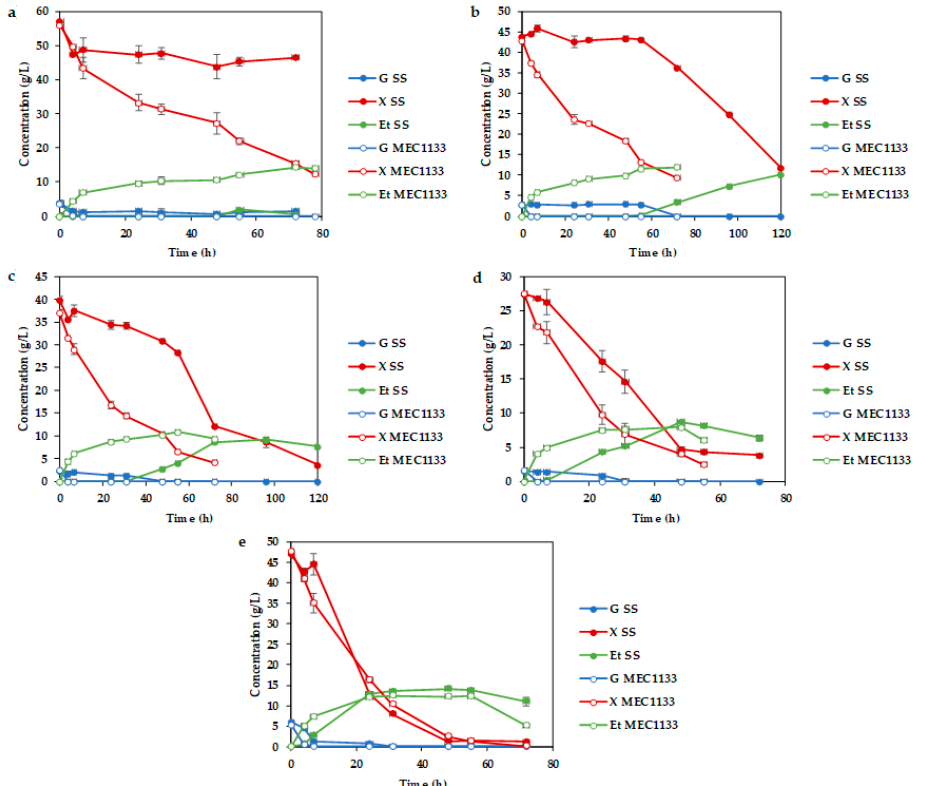
Figure 3. Time course of sugar consumption, glucose (G) and xylose (X), and ethanol (Et) production for media of non-detoxified hydrolysate at percentages of ( a ) 100%, ( b ) 80%, ( c ) 60%, and ( d ) 50%, and detoxified hydrolysate at ( e ) 100%, for S. stipitis (SS) and recombinant S. cerevisiae